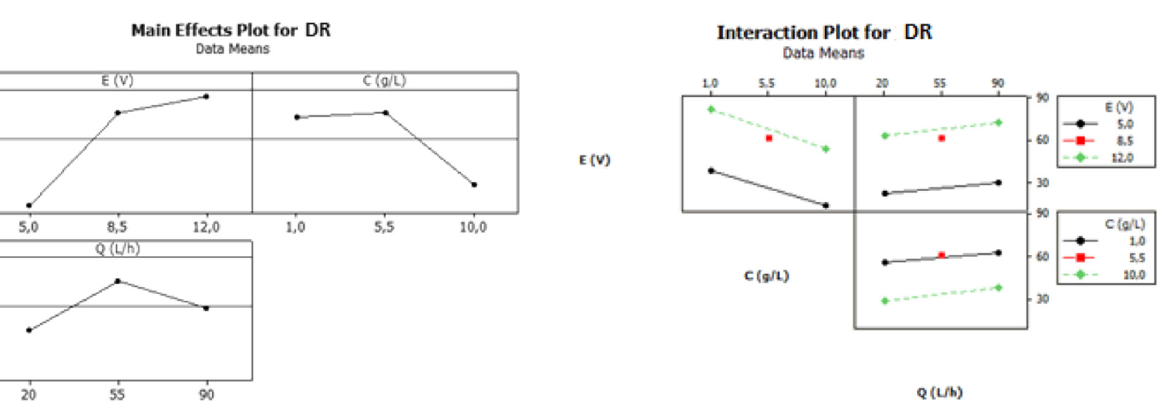
Fig. 4 Main effects plot for DR